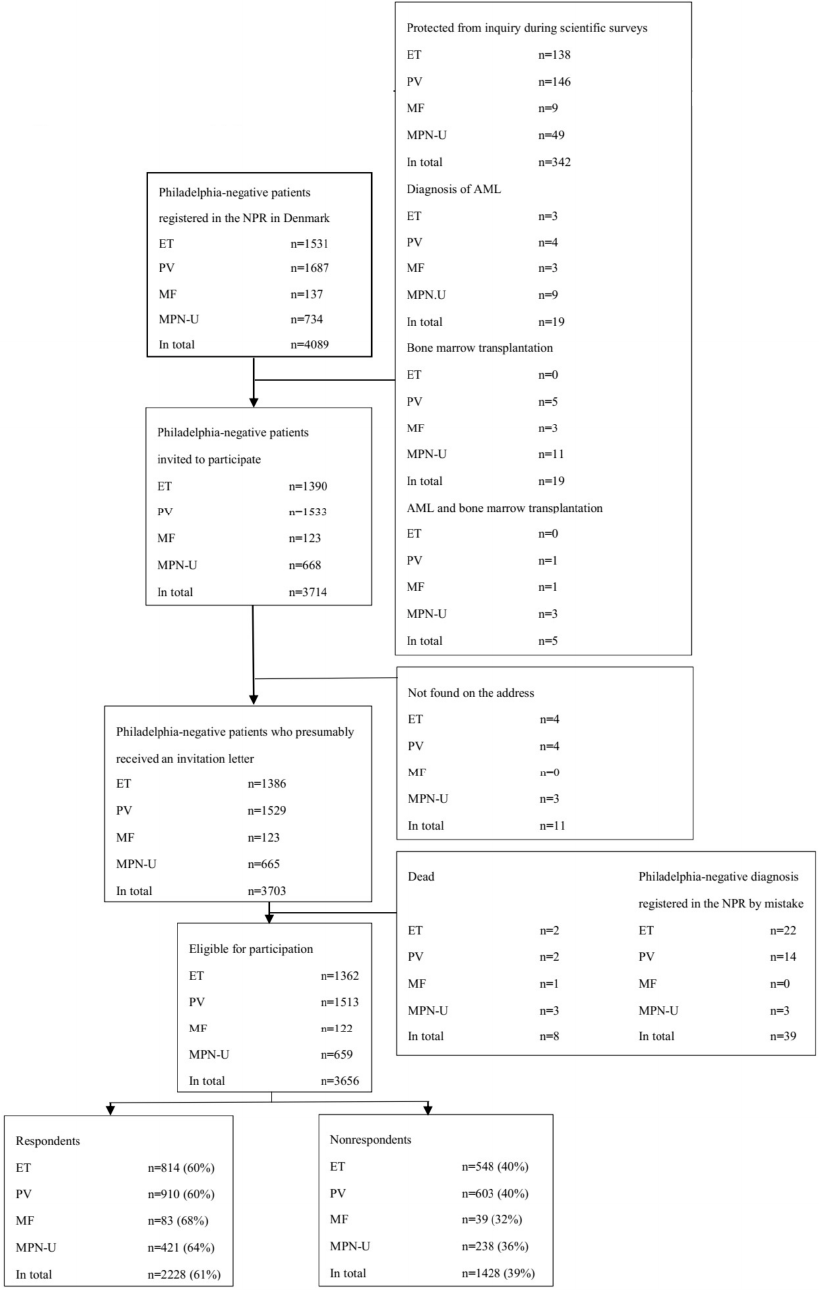
Figure 1. Flowchart for the survey population.